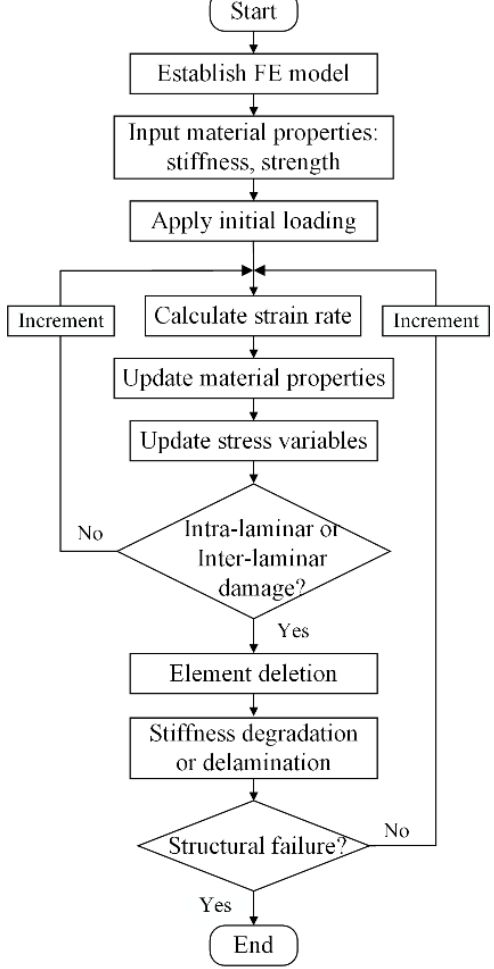
Figure 3. The simulation flowchart.